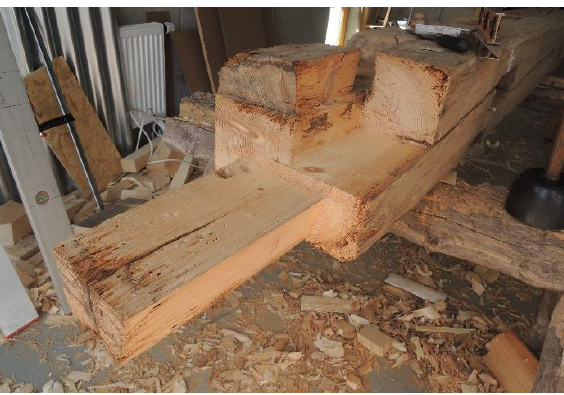
Figure 6. Gradual removal of the damaged wood at the beam bottom (after cleaning).